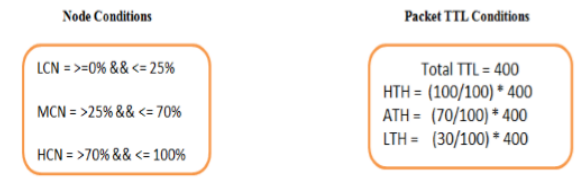
Fig 2: Node & TTL Thresholds: